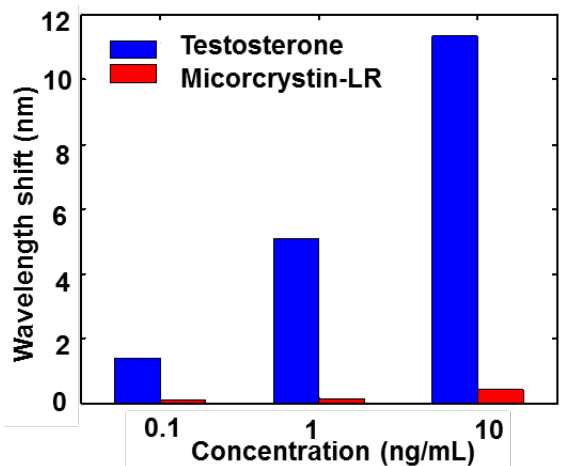
Figure 5. Wavelength shift of MIPs film coated chips, for the detection of different concentration of testosterone and microcystin-LR.